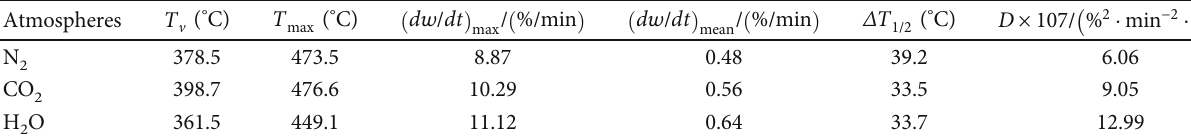
Table 2: Pyrolysis characteristic parameters of JM oil shale.